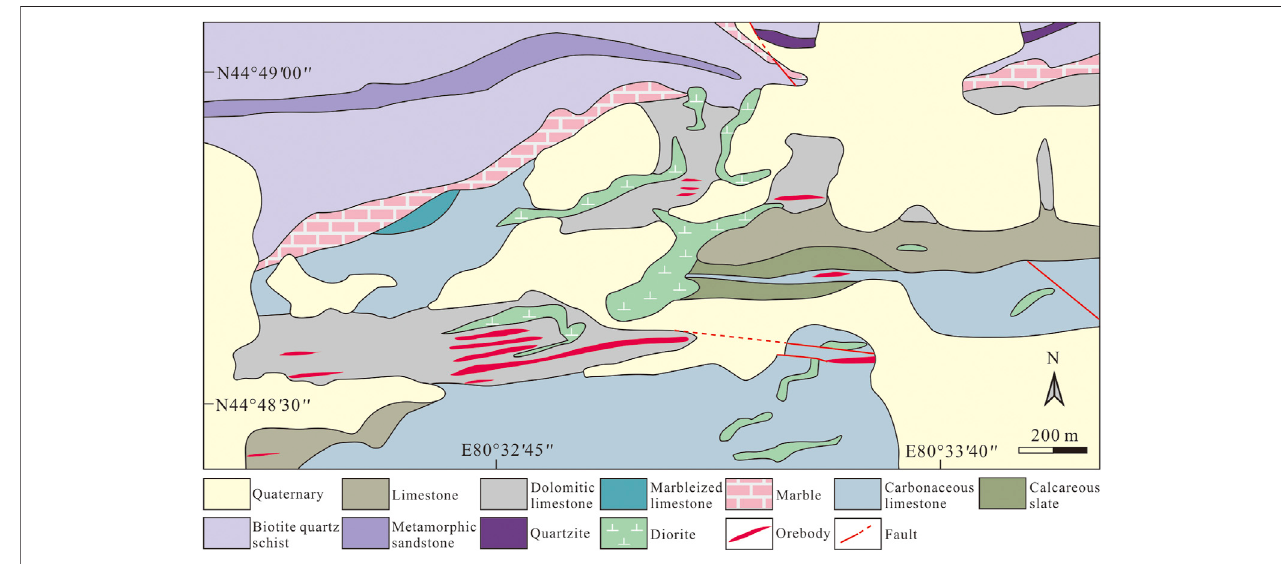
FIGURE 2 | Geological map of the Haerdaban Pb-Zn deposit (modi fi ed after Cheng et al., 2015).